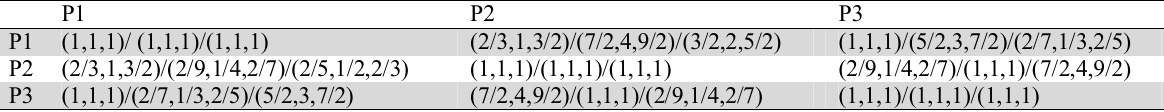
Linguistic Evaluations of Alternatives According to FL/GPA/OP